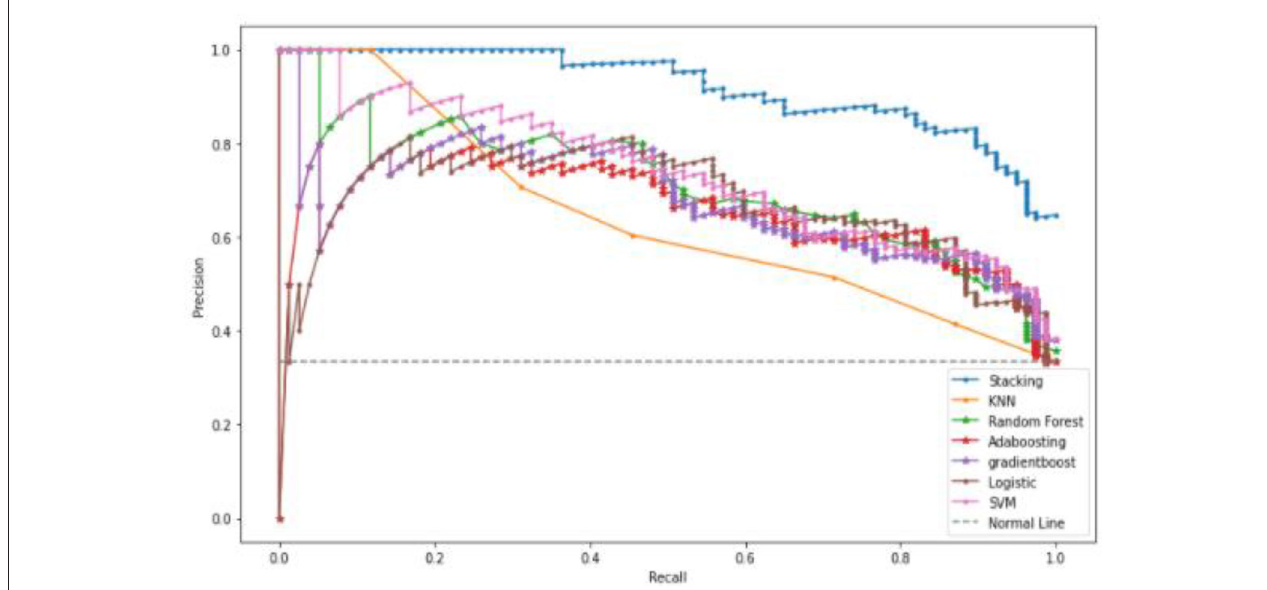
FIGURE 9 | Precision-Recall Curve of the proposed system and various machine learning